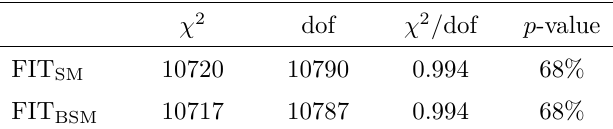
Table 4 . Goodness of the central fit results for the SM amplitude M C (FIT ) obtained by comparison with the BESIII data set M 6 C BSM 1